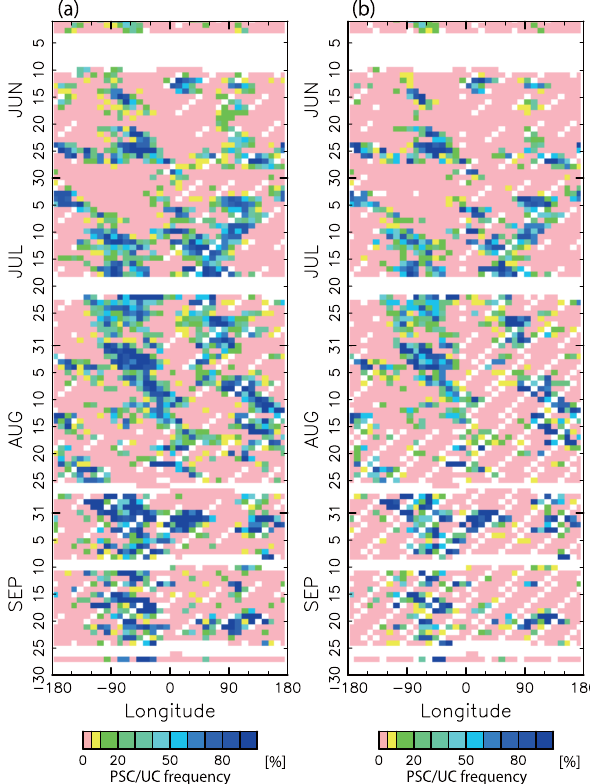
Fig. 1. Hovm¨oller diagrams of PSC/UC frequency from (a) the CALIPSO lidar Level 1B data and (b) CALIPSO lidar Level 2 VFM data, both averaged within an altitude range of 9–11km in the lati- tude range of 70–75 ◦ S for the austral winter of